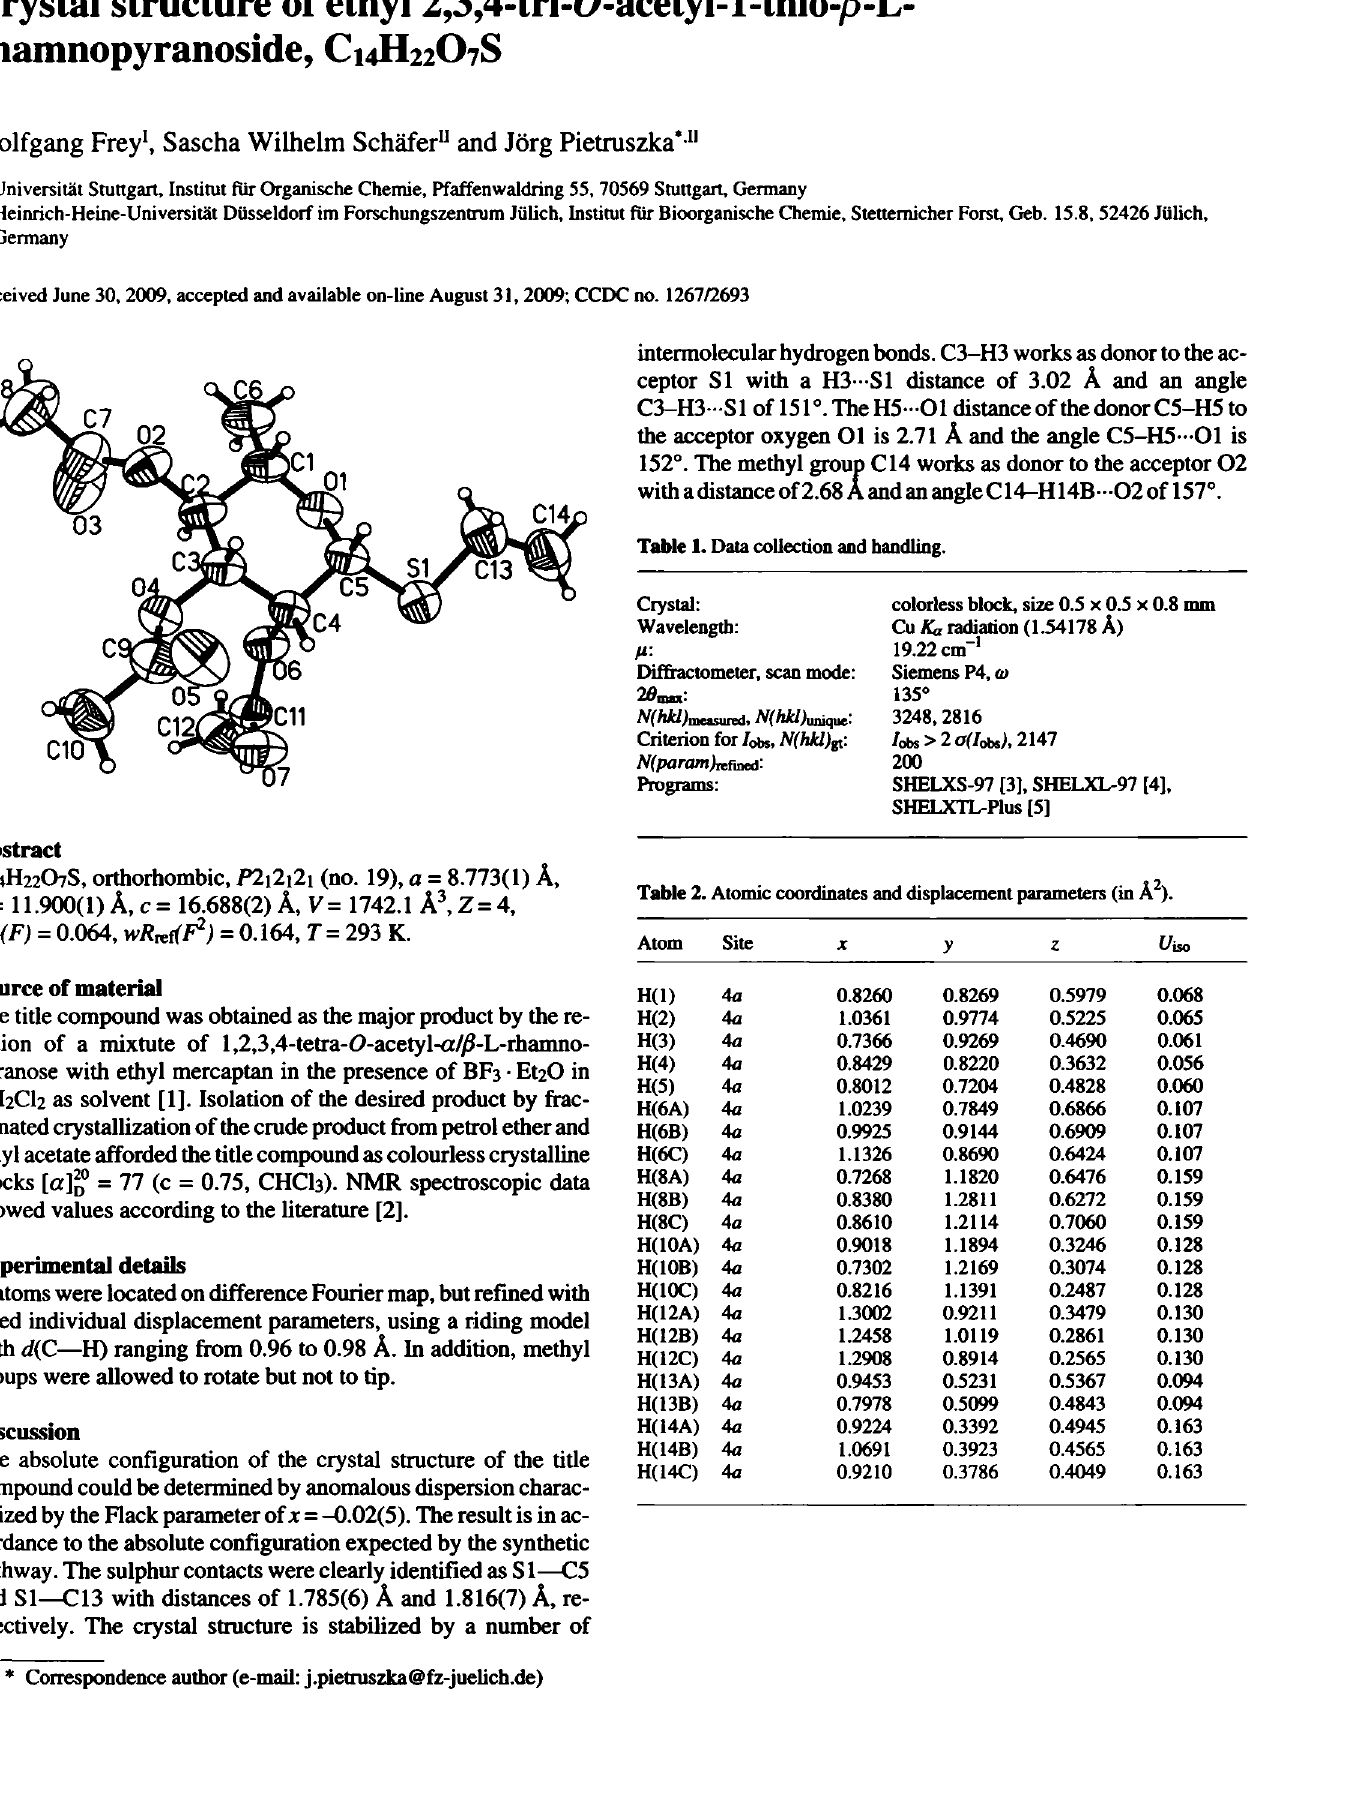
Table 1. Data collection and handling.